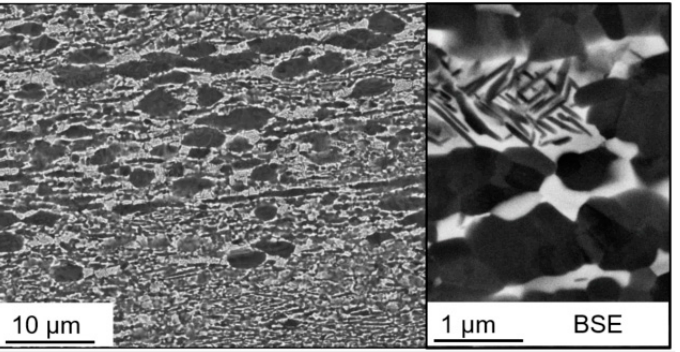
Figure 3. SEM image (BSE mode = backscattered electron image) of initial microstructure showing globular α primary and needle-like α secondary (dark phase) inside the β -matrix (bright